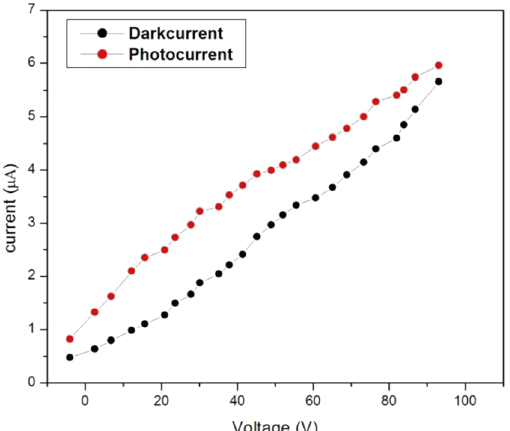
Figure 7. Photoconductivity